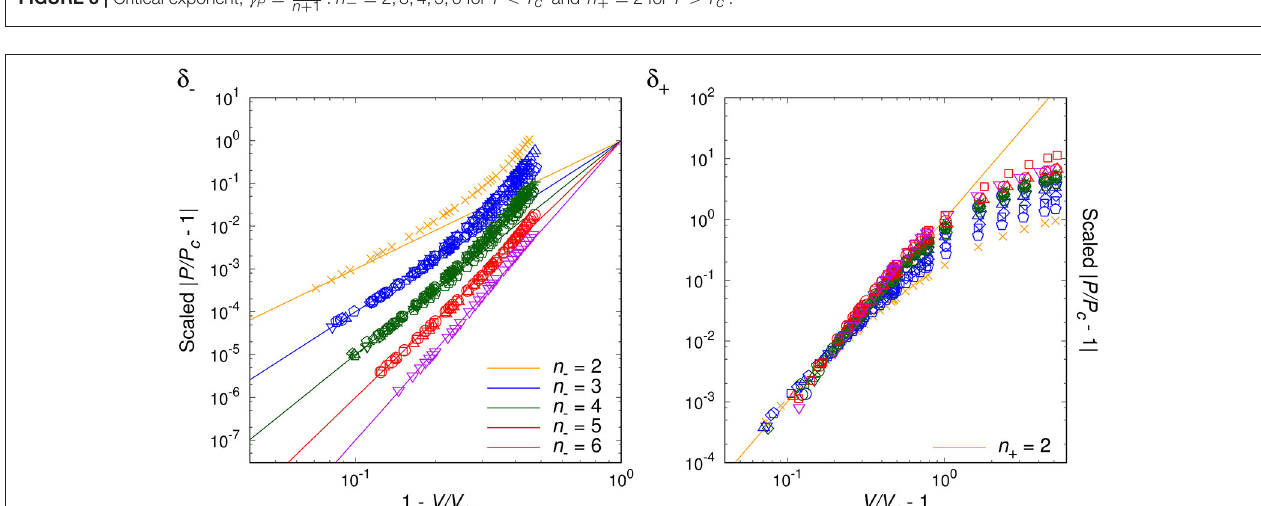
FIGURE 4 | Critical exponent, δ = n + 1: n − = 2,3,4,5,6 for V < V c and n + = 2 for V > V c .